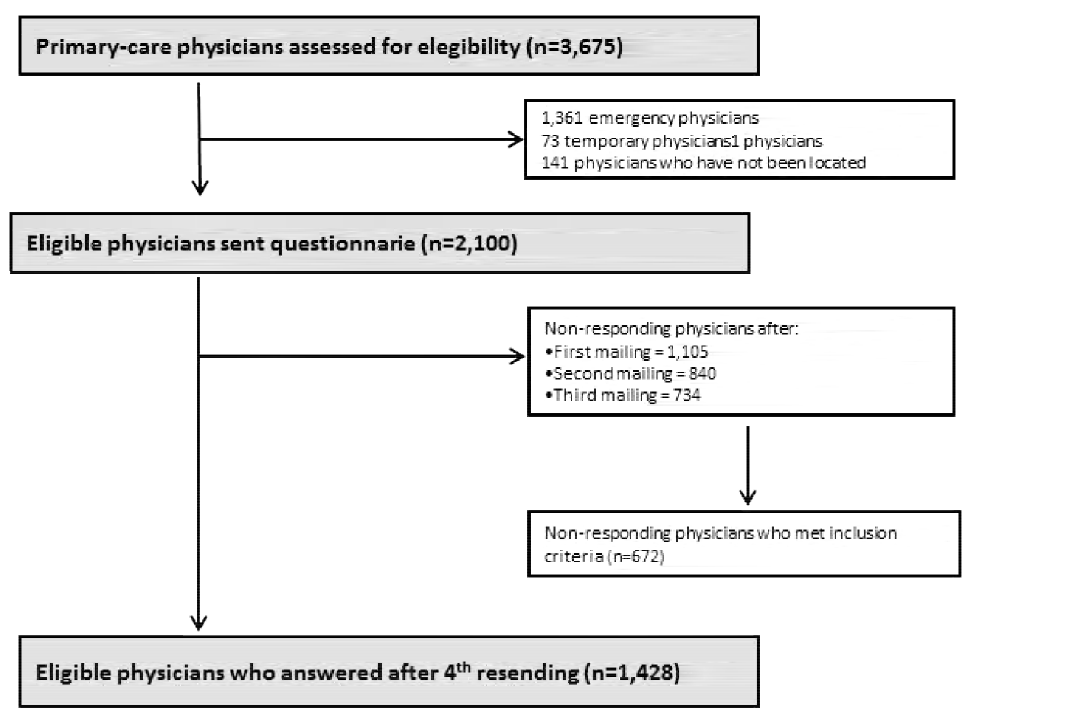
Fig 1. Flow of participants through the